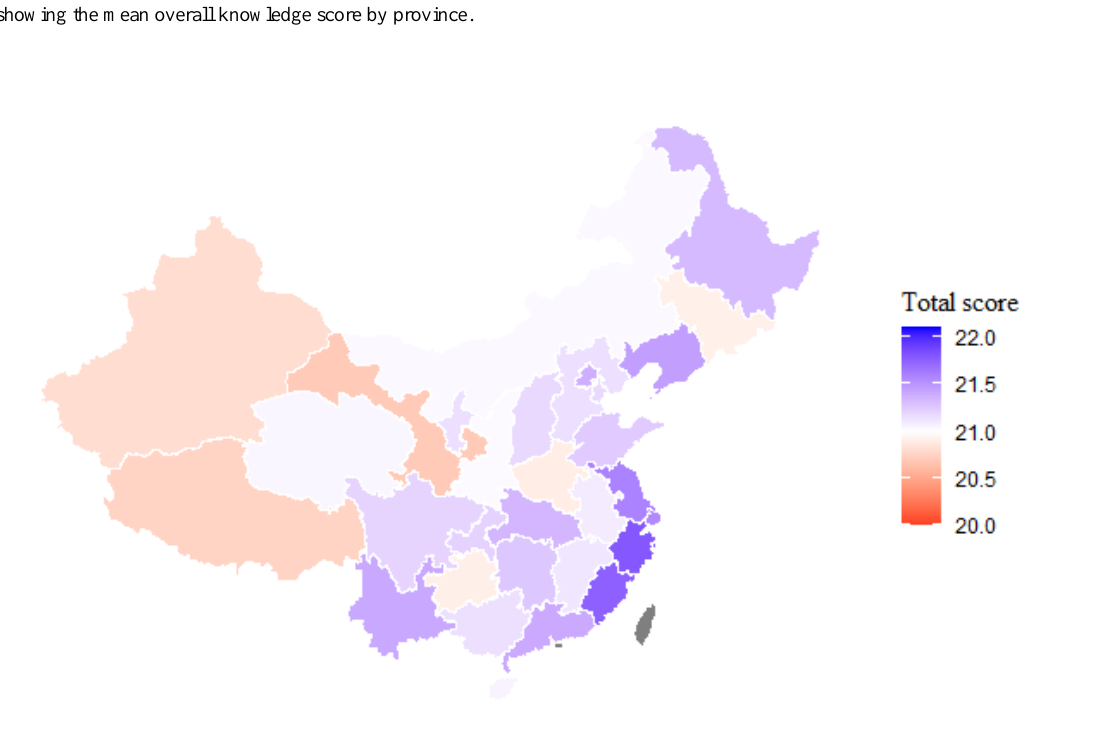
common flu who die from the flu, participants’median response was 0.75% (IQR 0.10%-1.00%). Almost all (96.4%, 95% CI 96.0%-96.8%) participants identified that older adults were the age group most likely to die from